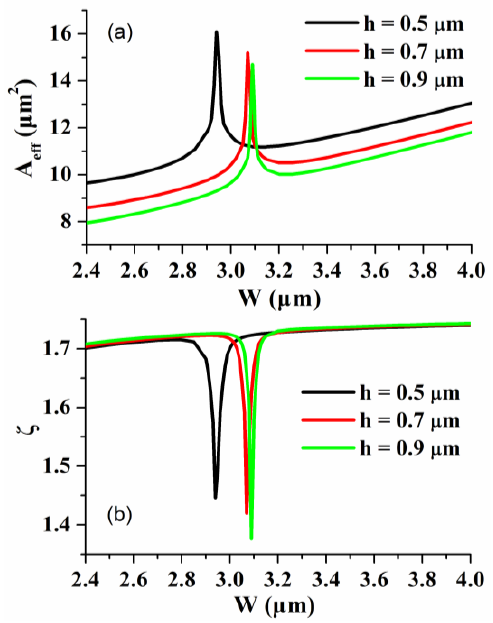
Figure 7. ( a ) Effective mode field area A eff and ( b ) mode overlap factor ζ of pump, signal and idler TE 00 waves calculated as a function of rib width W in the range of 2.4–4.0 µ m for different rib heights h = 0.5, 0.7 and 0.9 µ m. Other input parameters are H = 1 µ m, α = 78 ◦ and λ = 3.3 µ m.